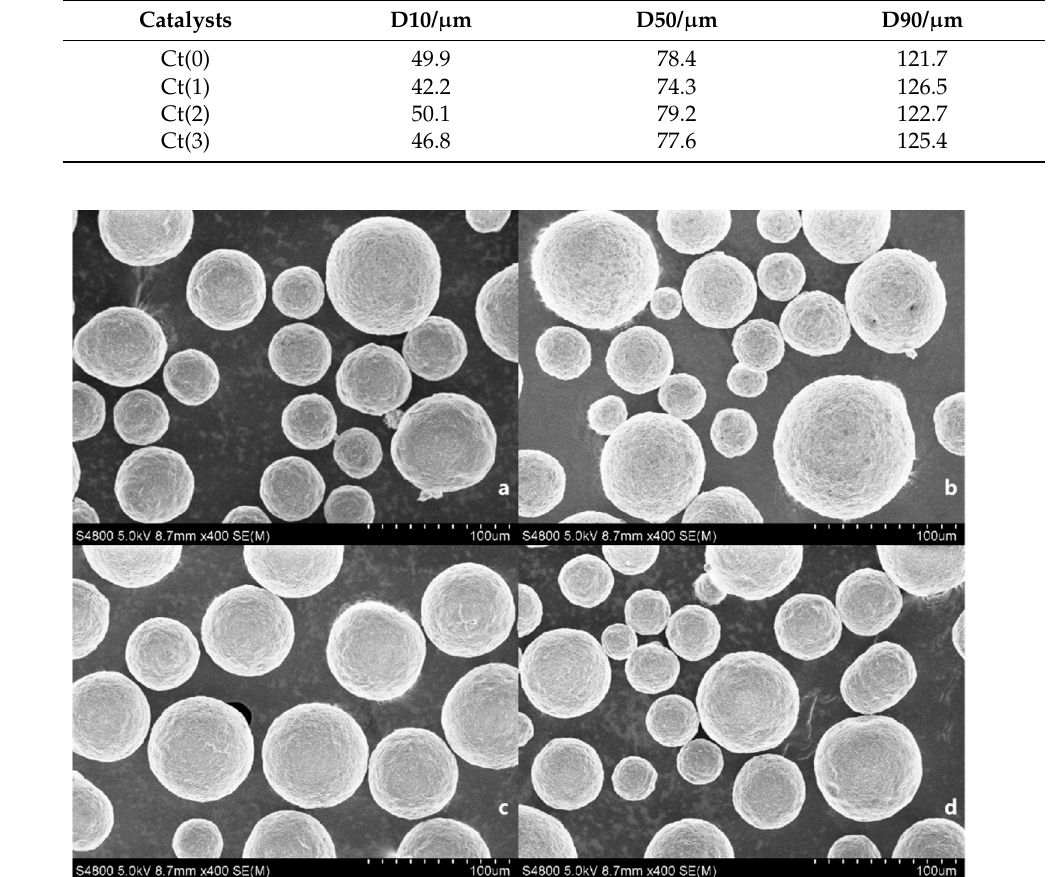
Table 5. Particle size distribution of titanium-containing mesoporous silica catalysts.